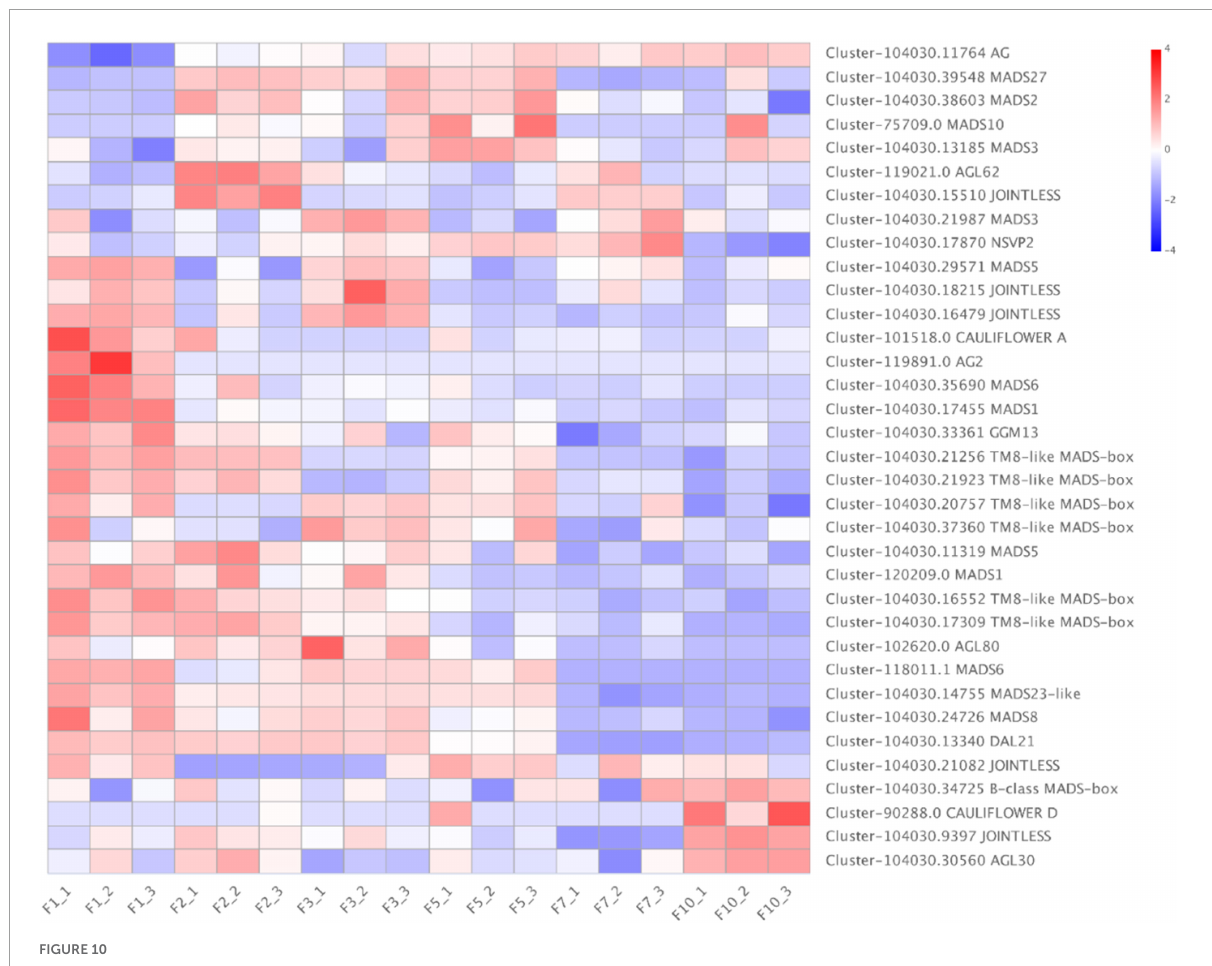
FIGURE10 Expression dynamics of Dacrydium pectinatum MADS-box unigenes differentially expressed during female cone development. The gradient-colored barcode at the top right indicates the log 2 (FC) value. Fold change is calculated based on the difference multiple of fragments per kilobase of transcript per million mapped reads (FPKM) in different periods. The unigenes expression in female cone was significantly higher than leaves, which was framed in red box, and lower was in blue box. 1, 2, 3, 5, and 10: January, February, March, May, and October 2019; F, female cones. Each group contains three repeats. AG, Agamous; AGL, Agamous-like MADS-box